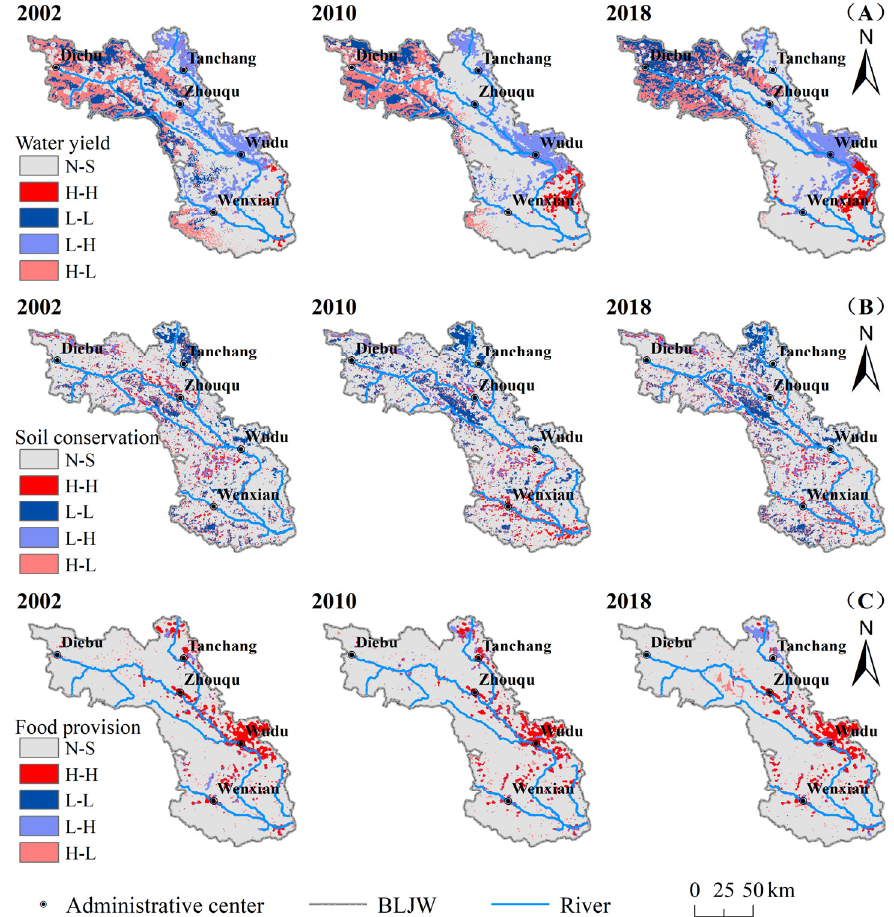
Figure 5. Cluster maps for the ESs supply–demand in the BLJW from 2002 to 2018. Note: H–H: high